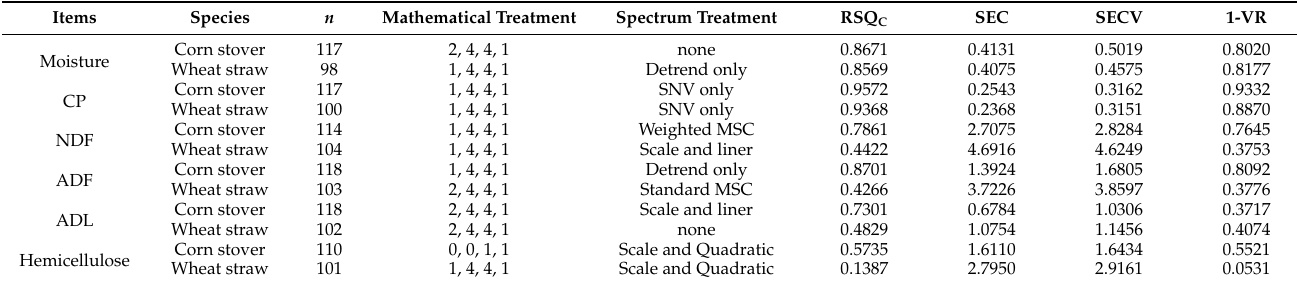
Table 3. Optimal NIRS prediction models of corn stover and wheat